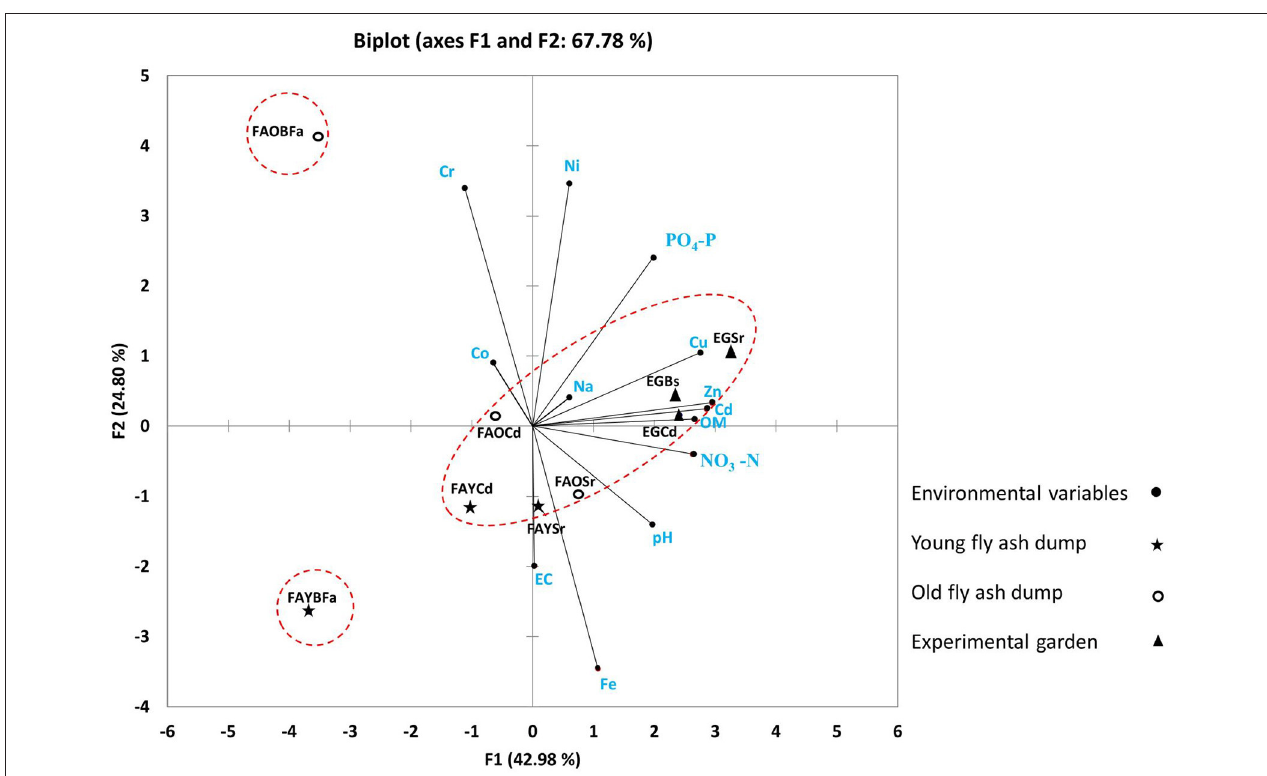
FIGURE 1 | Principal component analysis showing the positions of rhizosphere ash/soil samples of S. ravennae and C. dactylon and non-rhizosphere (bulk) ash/soil from fly ash dumps of different ages and experimental garden. Based on geochemical properties, the rhizosphere and non-rhizosphere fly ash are separated depicting substantial differences. S. ravennae rhizosphere samples separated out from C. dactylon rhizosphere samples along the secondary axis (in this figure) suggesting a noticeable effect of plant species on geochemical traits of fly ash than the age of dump. FAO and FAY, Old and young fly ash dumps; Sr, S. ravennae rhizosphere; Cd, C. dactylon rhizosphere; EG, experimental garden; Bs/BFa, Bulk soil/fly